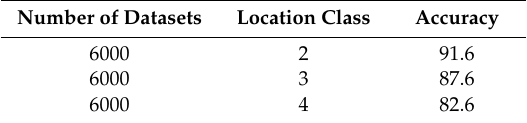
Table 6. Results of the dataset with the optimal number of samples: